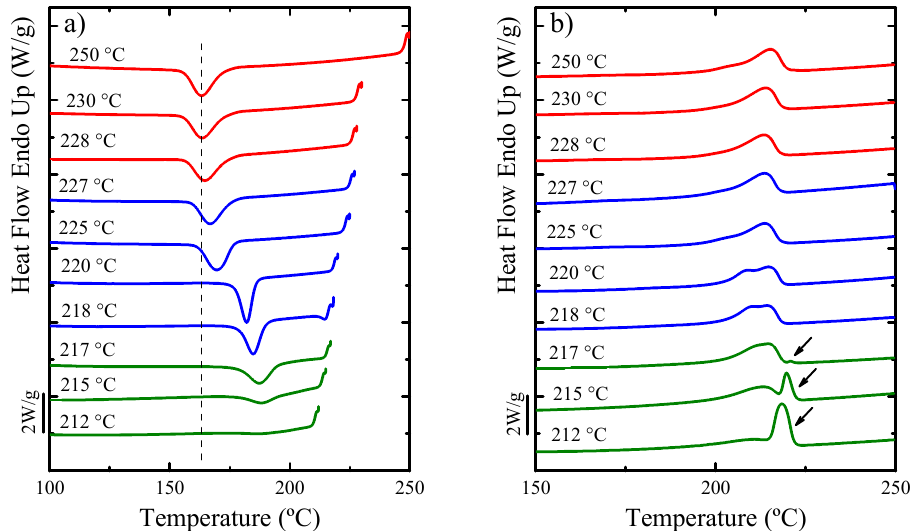
Figure 6. ( a ) DSC cooling scans for neat PA6 after 5 min at the indicated T s values and ( b ) subsequent heating scans after the cooling runs shown in ( a ). The colors indicate the different self-nucleation Domains : red for Domain I , blue for Domain II and green for Domain III . The dashed vertical line in ( a ) has been drawn to indicate the standard peak crystallization value for PA6.